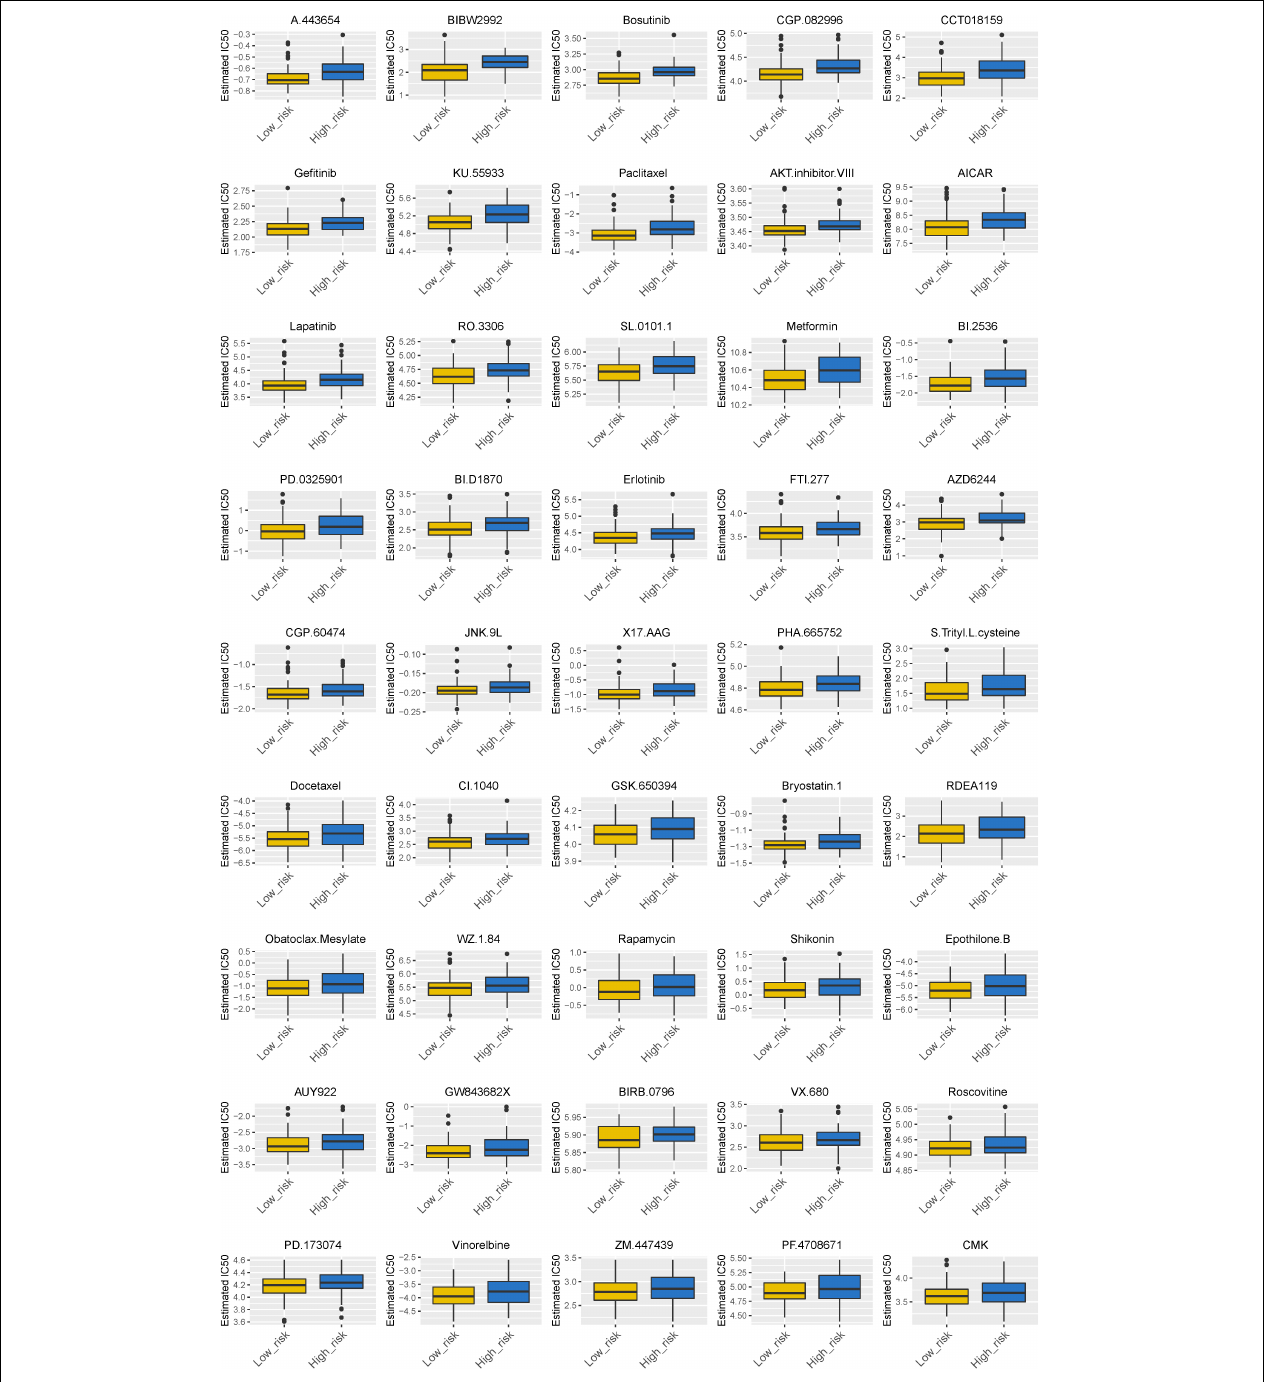
FIGURE 7 | Different chemotherapeutic responses in high- and low-risk patients with ESCC. ( P <